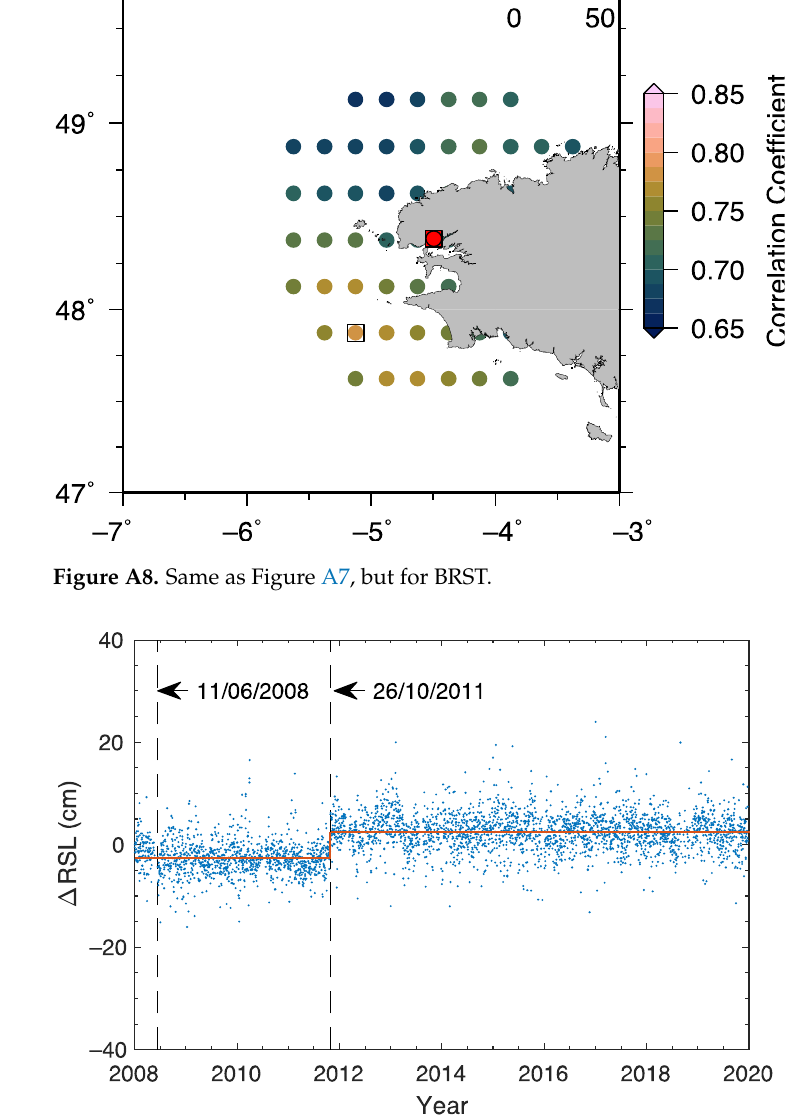
Figure A9. The differences in relative sea levels measured by GNSS-IR at BRST and the co-located tide-gauge records. GNSS station and tide gauge are 293 m apart. Blue dots are the difference between the two types of measurements, while the red line is the fit to the differences. The two dash lines indicate change of equipment: the GNSS antenna changed from LEIAT504 to LEIAT504GG on 11 June 2008, and from LEICA (LEIAT504GG) to TRIMBLE (TRM57971.00) on 26 October 2011.